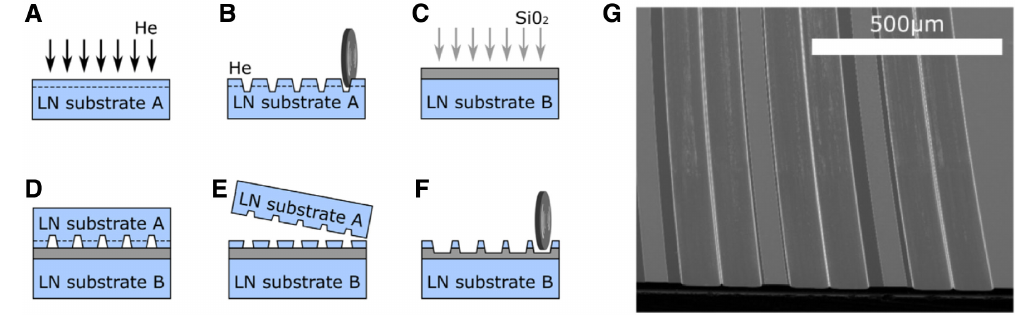
Figure 5: A standard fabrication process of diamond dicing. (A–F) Show the standard fabrication process of diamond dicing and (G) shows a scanning electron microscope photograph of the waveguide made by using diamond dicing. Reprinted with permission from Volk et al. [60]. © The Optical